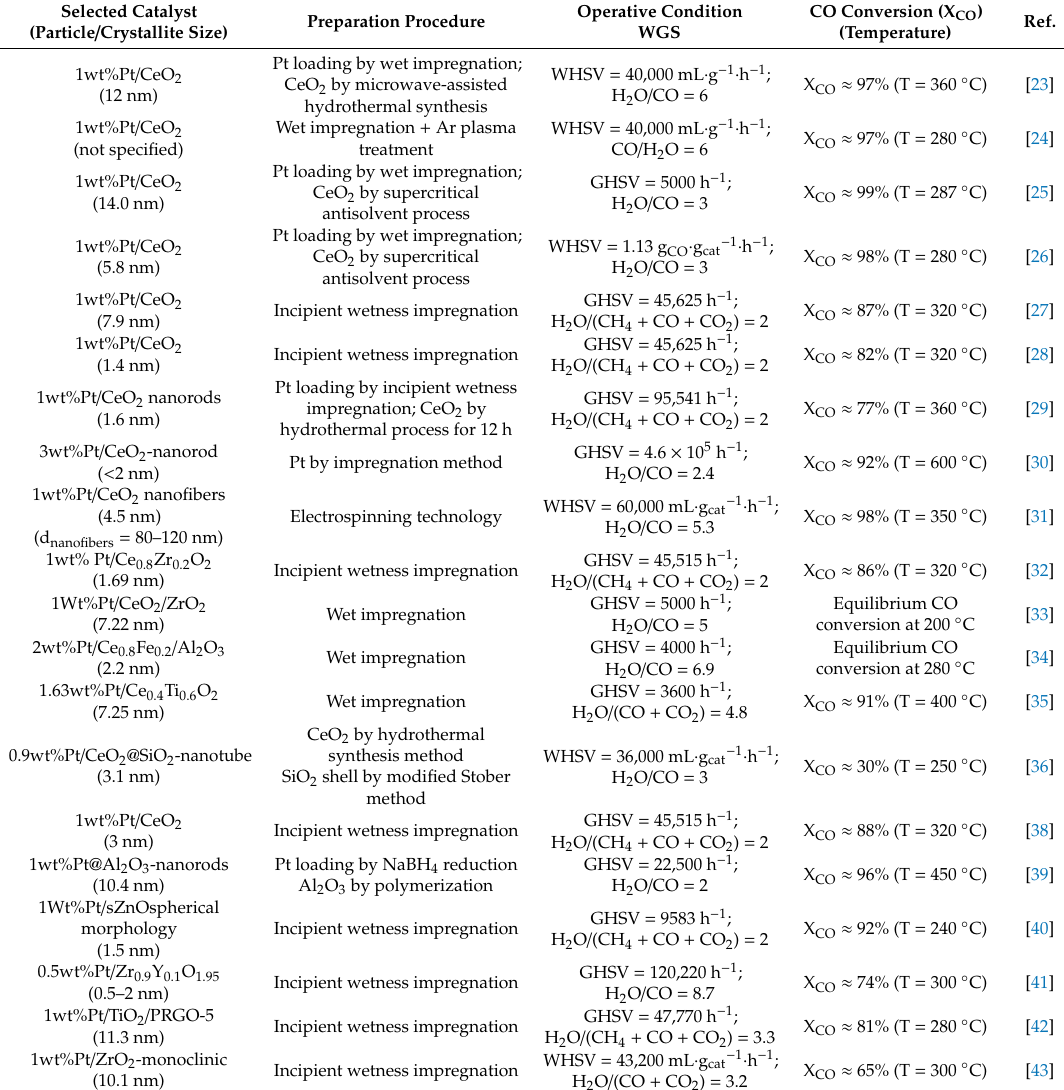
Table 1. Selected catalysts per article reported in the Section 2.1: Monometallic Catalysts: the supports. Selected Catalyst (Particle / Crystallite